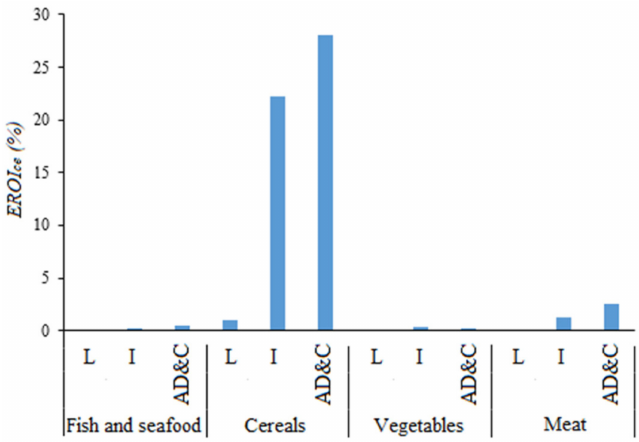
Figure 9. Energy return on investment–Circular economy index for the considered